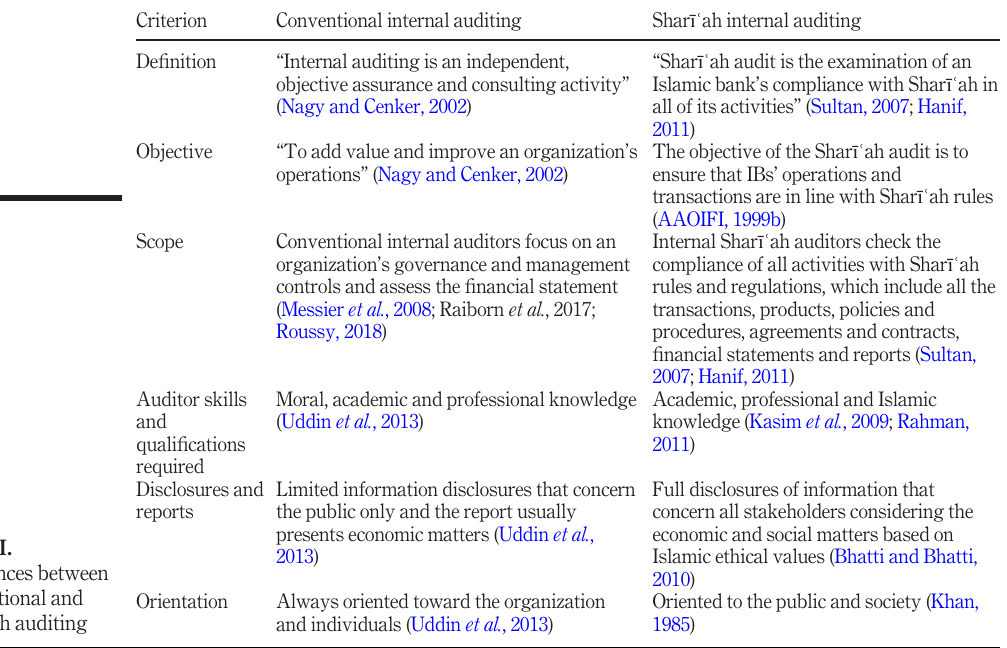
Table I. Differences between conventional